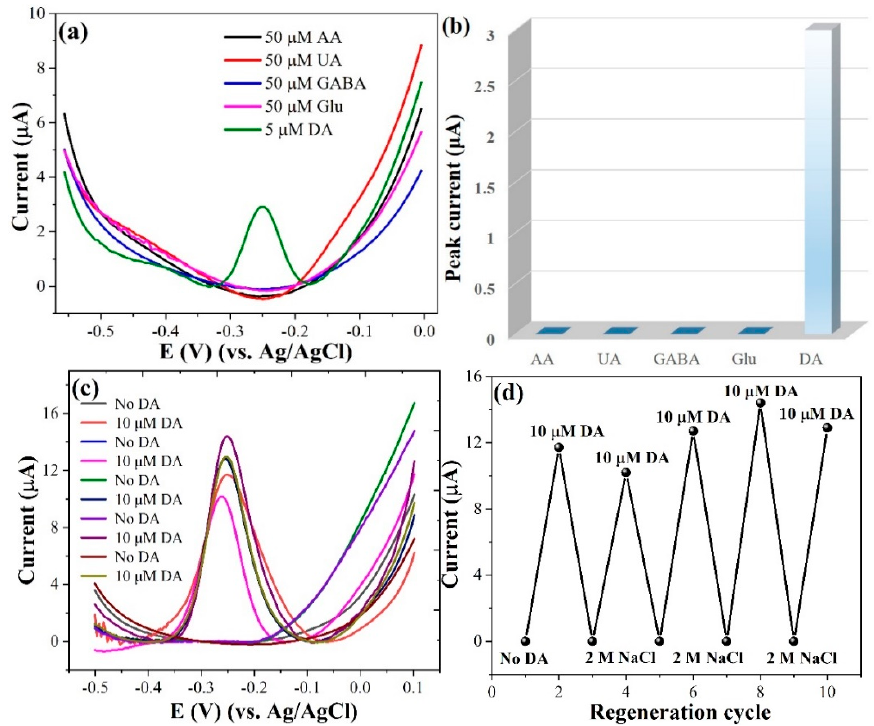
Figure 2. ( a ) SWV current responses and ( b ) column comparison graph of the corresponding current of the split aptamer-based electrochemical sandwich assay for the detection of dopamine (DA) and its analogues: ascorbic acid (AA), uric acid (UA), gamma-aminobutyric acid (GABA), and glutamate (Glu); ( c ) SWV curves and ( d ) the corresponding current responses showing the regeneration of aptasensors after repeated rinsing of the amperometric aptasensor with a 2 M NaCl solution.